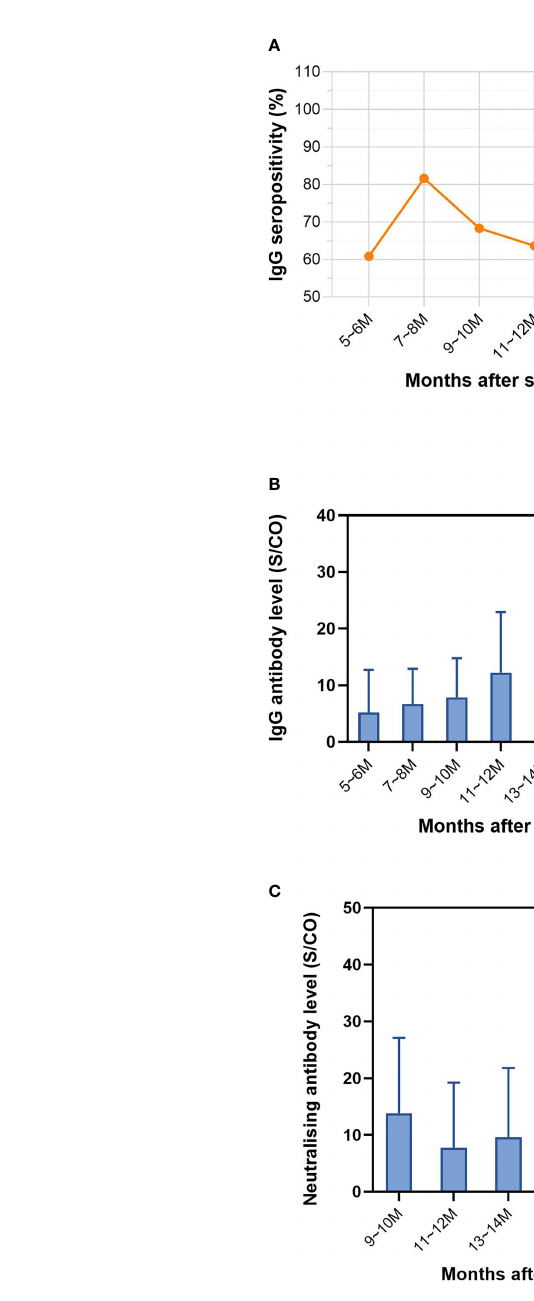
FIGURE 2 | Dynamics of the IgG positive rate and antibody levels during the two follow-up rounds. The length of follow-up ranged from 5.4 months to 17.4 months. At two-month intervals, the horizontal axis has been divided into seven equal parts, 5~6 months, 7~8 months, 9~10 months, 11~12 months, 13~14 months, 15~16 months and 17~18 months. (A) Trends in IgG positive rate over months after symptom onset in overall, unvaccinated and vaccinated convalescent patients. (B) Trends in IgG antibody levels over months after symptom onset in overall, unvaccinated and vaccinated convalescent patients. (C) Trends in neutralising antibody levels over months after symptom onset in overall, unvaccinated and vaccinated convalescent patients. P values were determined applying a two-tailed Mann- Whitney U test. P<0.05 was considered to be statistically signi fi